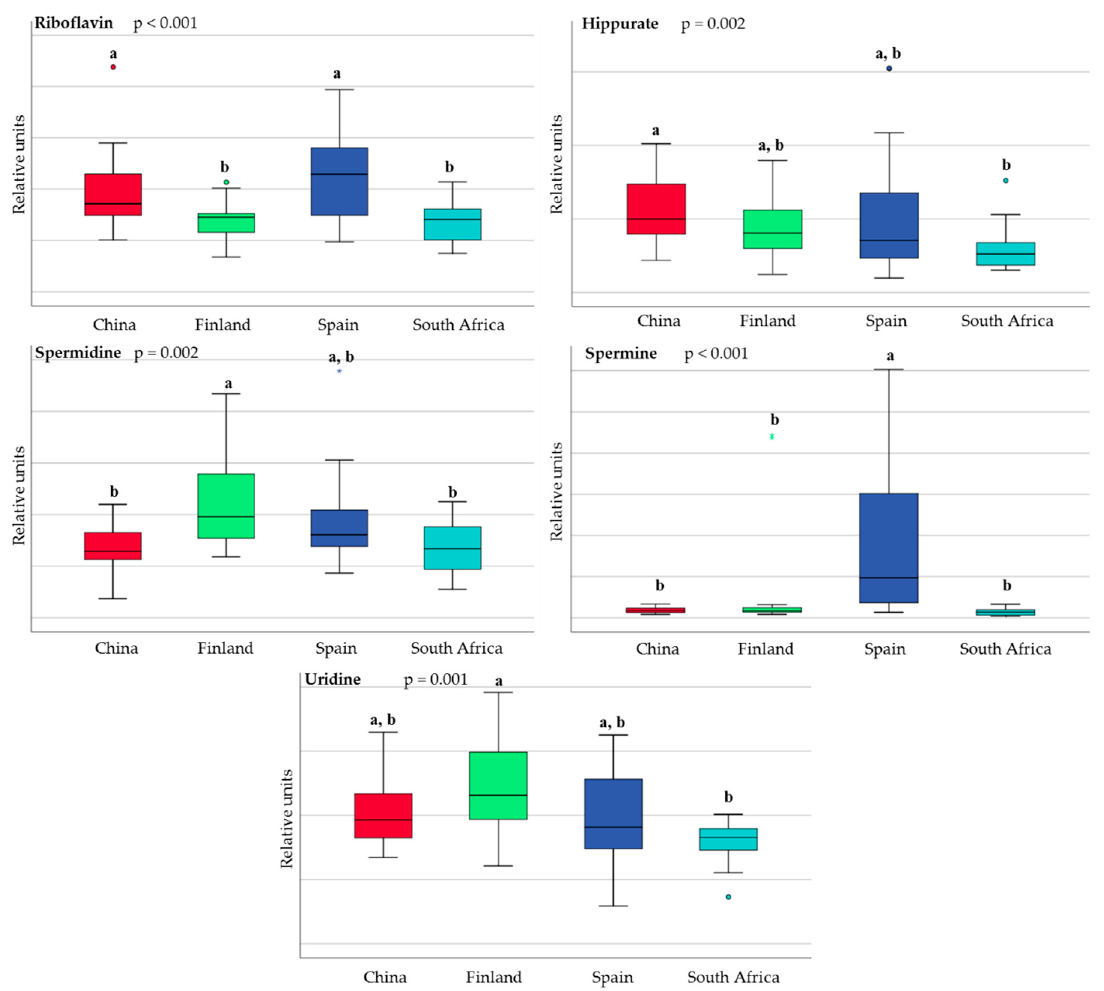
Figure 6. Box and whisker plot showing statistical significant differences in other metabolites in breast milk in samples from China (red), Finland (green), Spain (blue) and South Africa (pale bue). Data are expressed in relative units. Each bar represents the smallest observation, lower quartile ( Q1 ), median, upper quartile ( Q3 ) and largest observation. Circles and stars indicate outlier data. Differences among countries were calculated using the Kruskal–Wallis test. Unlike letters indicate statistically significant differences among countries.